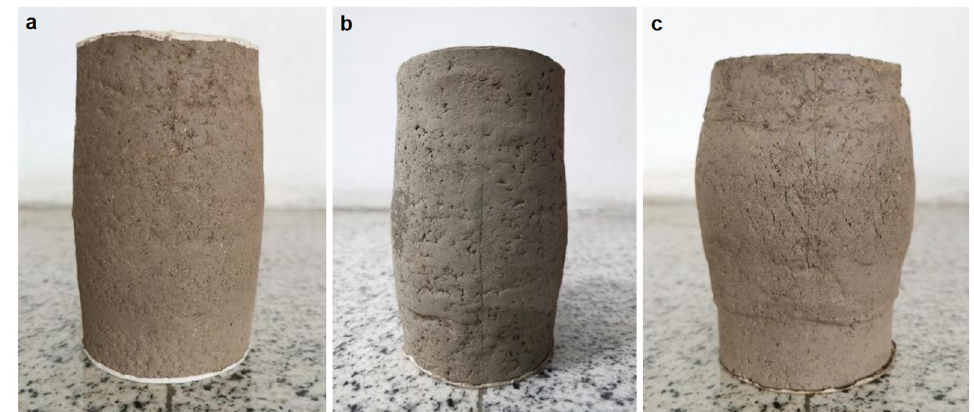
Figure 4. Soil specimen instances after creep tests. Specimen ( a ), under presupposed confining pressure σ 3 = 200 kPa. Specimen ( b ), under presupposed confining pressure σ 3 = 150 kPa. Specimen ( c ), under presupposed confining pressure σ 3 = 100 kPa. ( σ 1 − σ 3 ) exerted to the three specimens ranges from 37.98 kPa~360.23 kPa. The original sizes of all the three specimens are d 0 = 61.8 mm and h 0 = 125